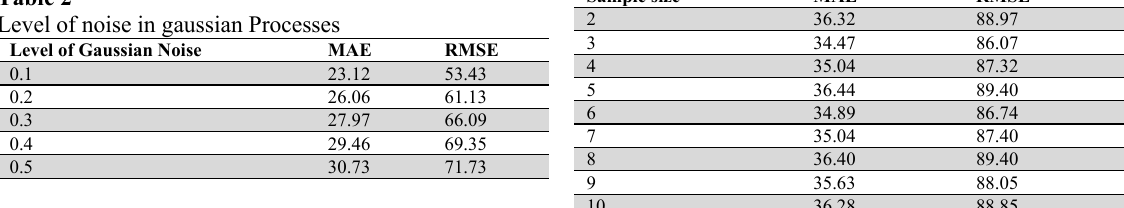
Sample Size in LMSLR Sample